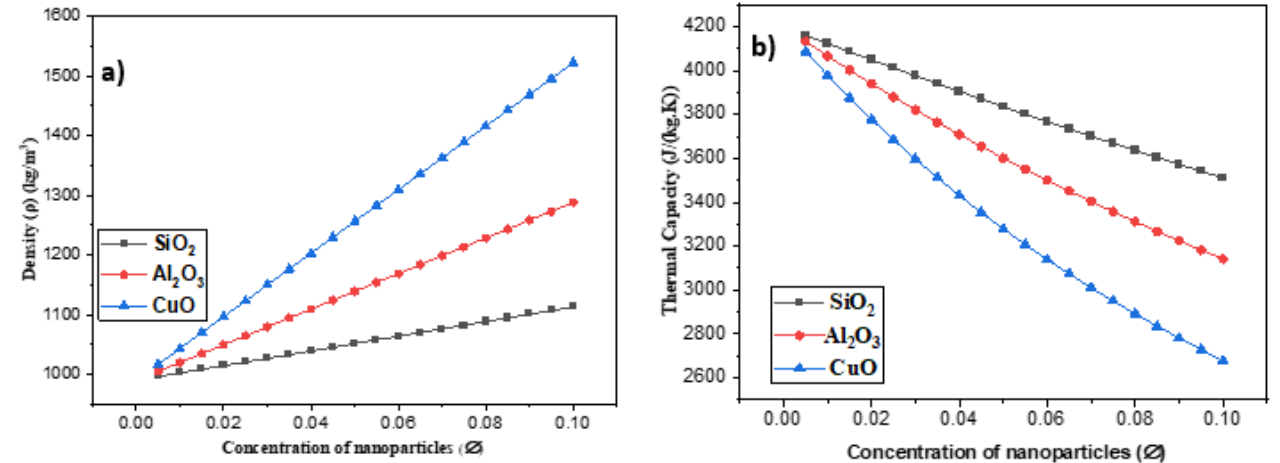
Figure 4. ( a ) The influence of nanoparticles on density and ( b ) nanoparticles’ influence on thermal capacity.